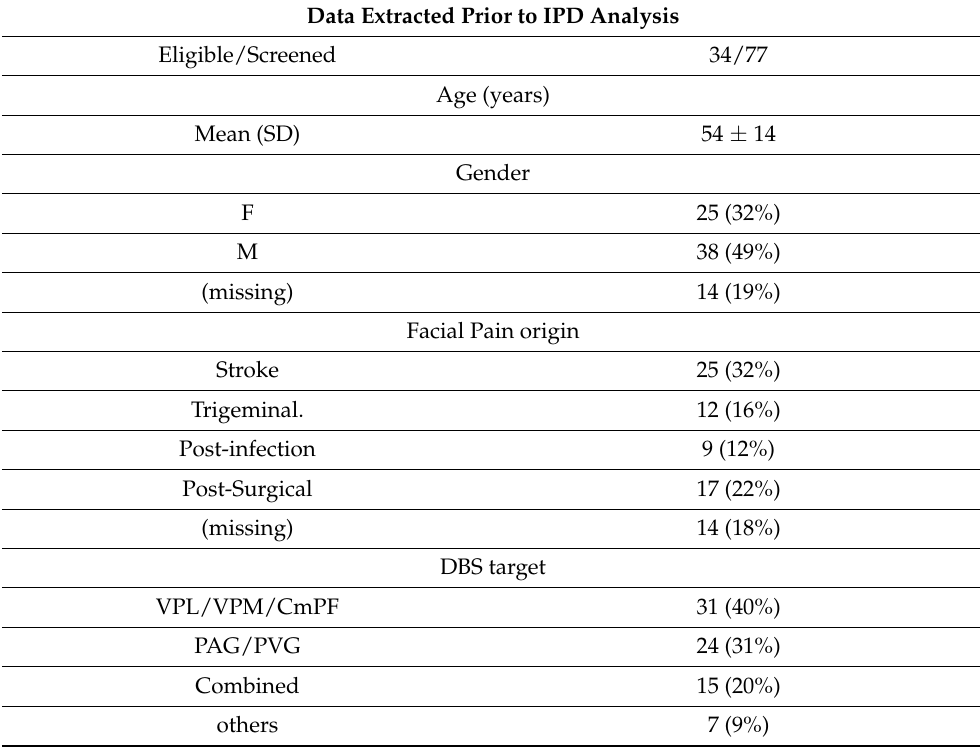
Table 1. Overview of the published data reporting the characteristics of the study participants as relevant to the meta-analysis (age, gender, facial pain etiology, and DBS